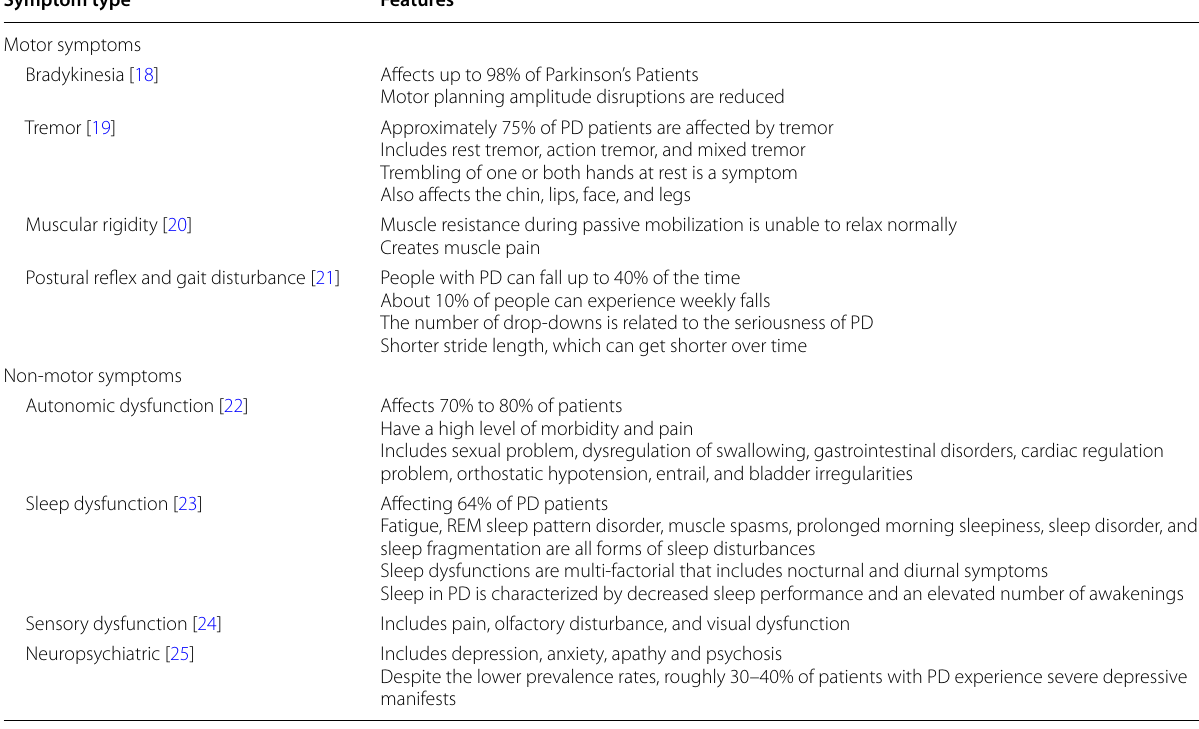
Table 1 Motor/non-motor symptoms Symptom